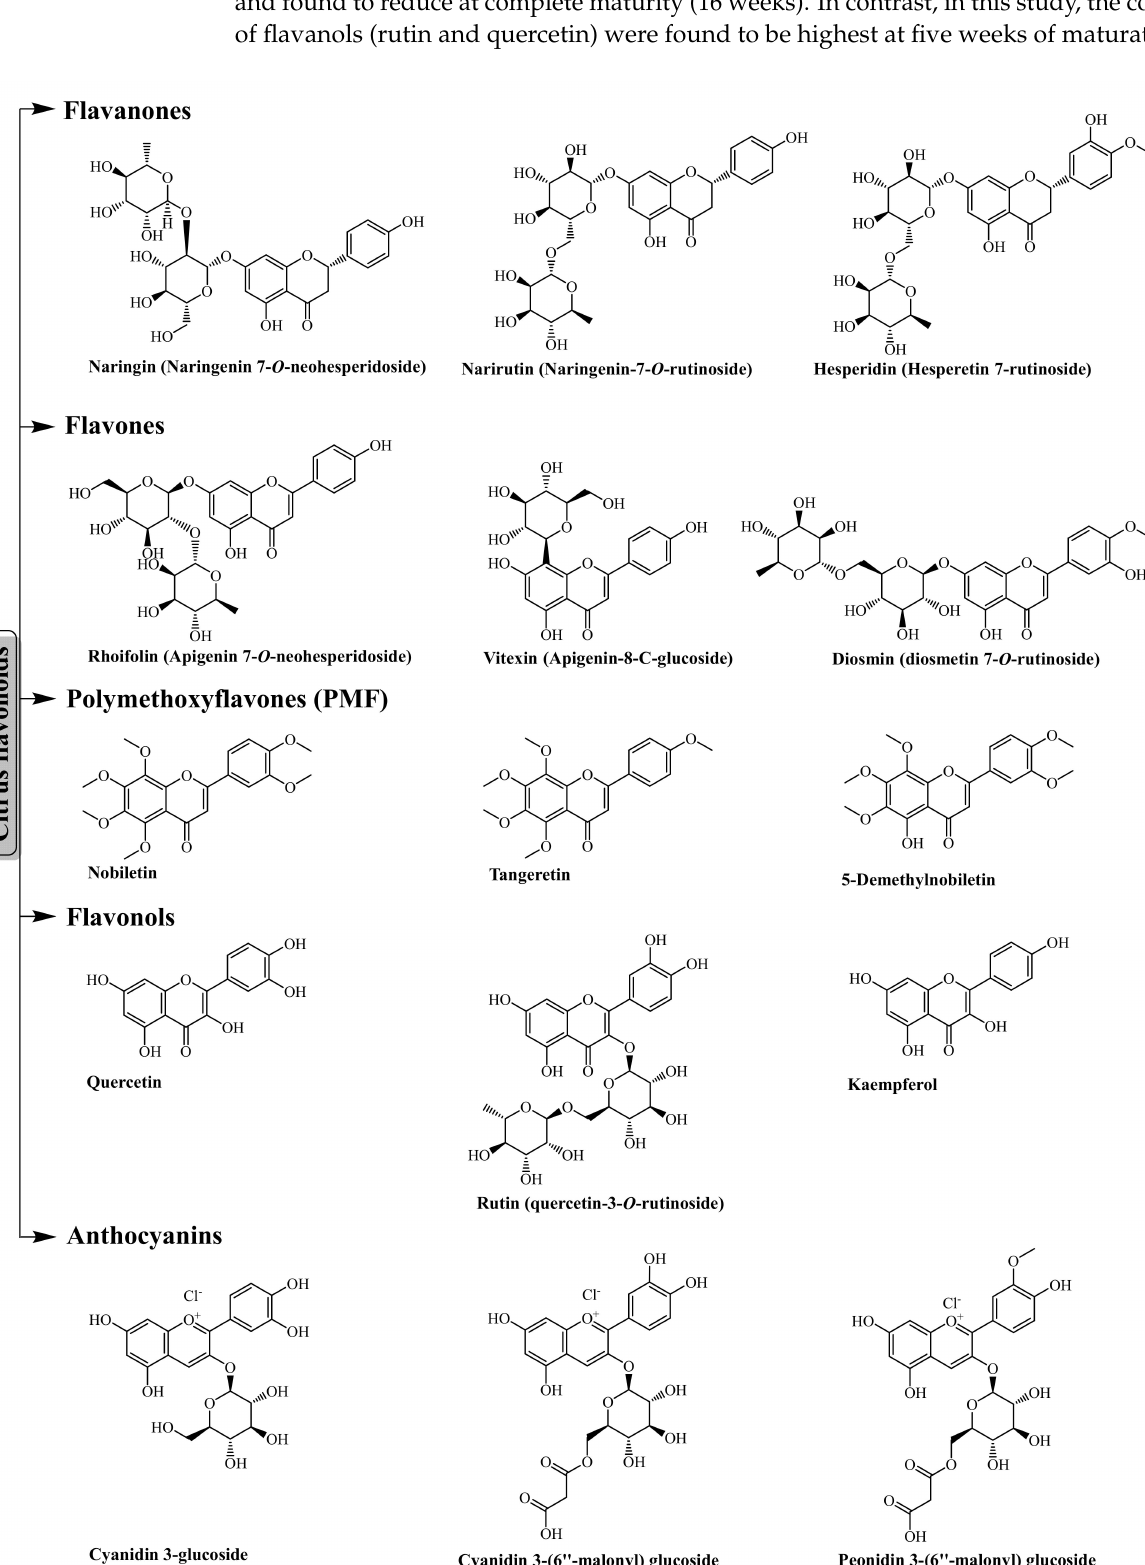
Figure 1. The major flavonoids of citrus